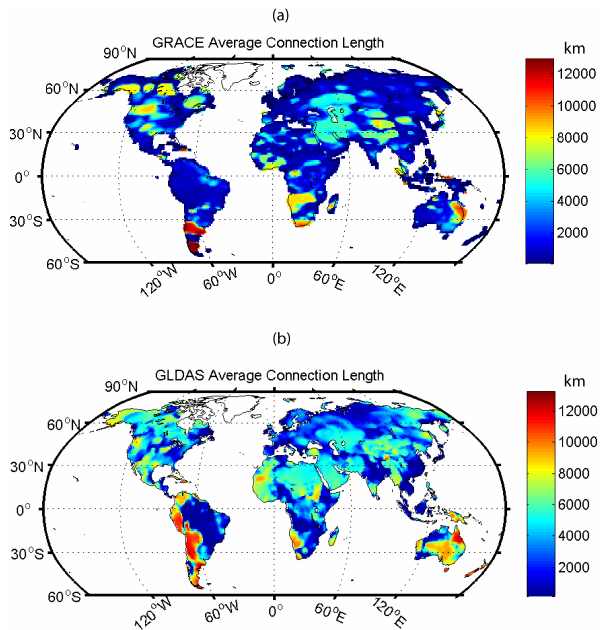
Figure 7. Map of average node connection lengths derived based on (a) GRACE and (b) GLDAS.